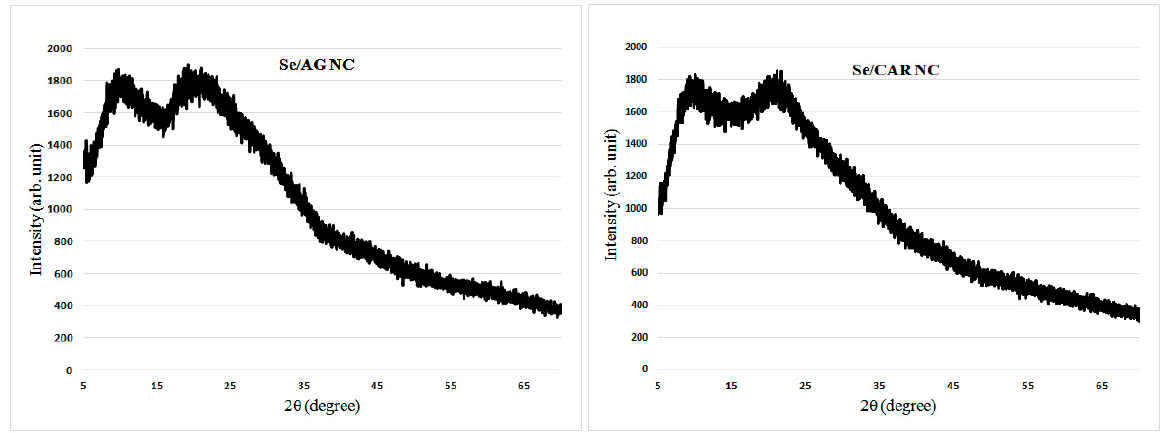
Figure 3. Typical diffractograms of Se/AG and Se CAR NCs. However, in the case of Se/ST NC, its diffractogram still showed weak reflexes, which coincided with a number of reflexes of the original ST used for the synthesis of Se/ST NC (Figure 4, coincidence is marked by vertical lines).